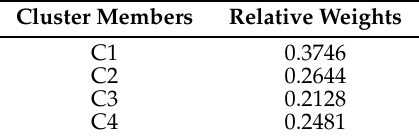
Table 1. Relative weights of cluster members.